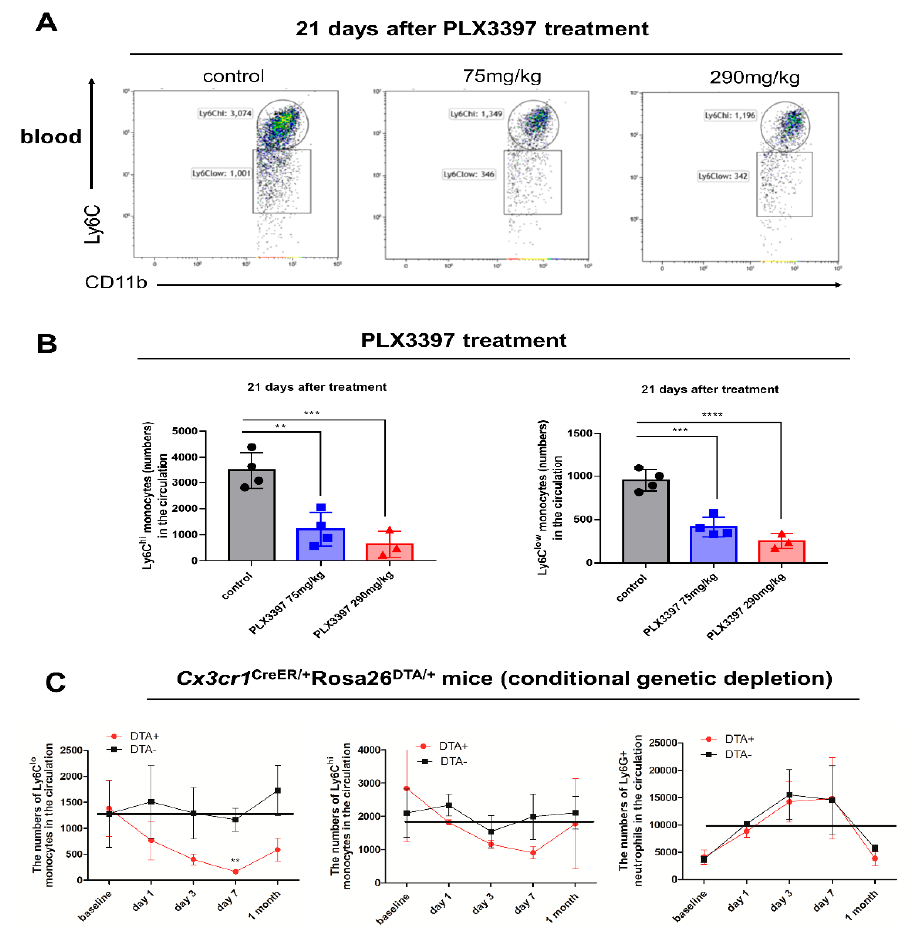
Figure 5. The numbers of circulating monocytes are reduced following both conditional genetic and pharmacological microglial depletion. ( A ) Representative flow cytometry plots of Ly6C hi and Ly6C low monocytes in the circulation following 21 consecutive days of PLX3397 diet treatment at different doses of 75 mg/kg and 290 mg/kg, respectively. Control mice were treated with normal diet. ( B ) The numbers of circulating Ly6C hi and Ly6C low monocytes (± SEM) during pharmacological microglial depletion periods (control, black bars; 75 mg/kg PLX3397 treatment, blue bars; 290 mg/kg PLX3397 treatment, red bars, n = 4, 4, 3, respectively). ( C ) Kinetic changes of circulating Ly6C hi monocytes, Ly6C low monocytes and Ly6G + neutrophils in Cx3cr1 CreER/+ Rosa26 DTA/+ mice treated with tamoxifen (baseline, n = 6; Cx3cr1 CreER/+ mice, black bars; n = 4, 4, 4, 5, respectively; Cx3cr1 CreER/+ Rosa26 DTA/+ mice, red bars; n = 3, 4, 4, 3, respectively). Statistical significance is indicated as ** p < 0.01, *** p < 0.001 and **** p < 0.0001 (ns: not significant).